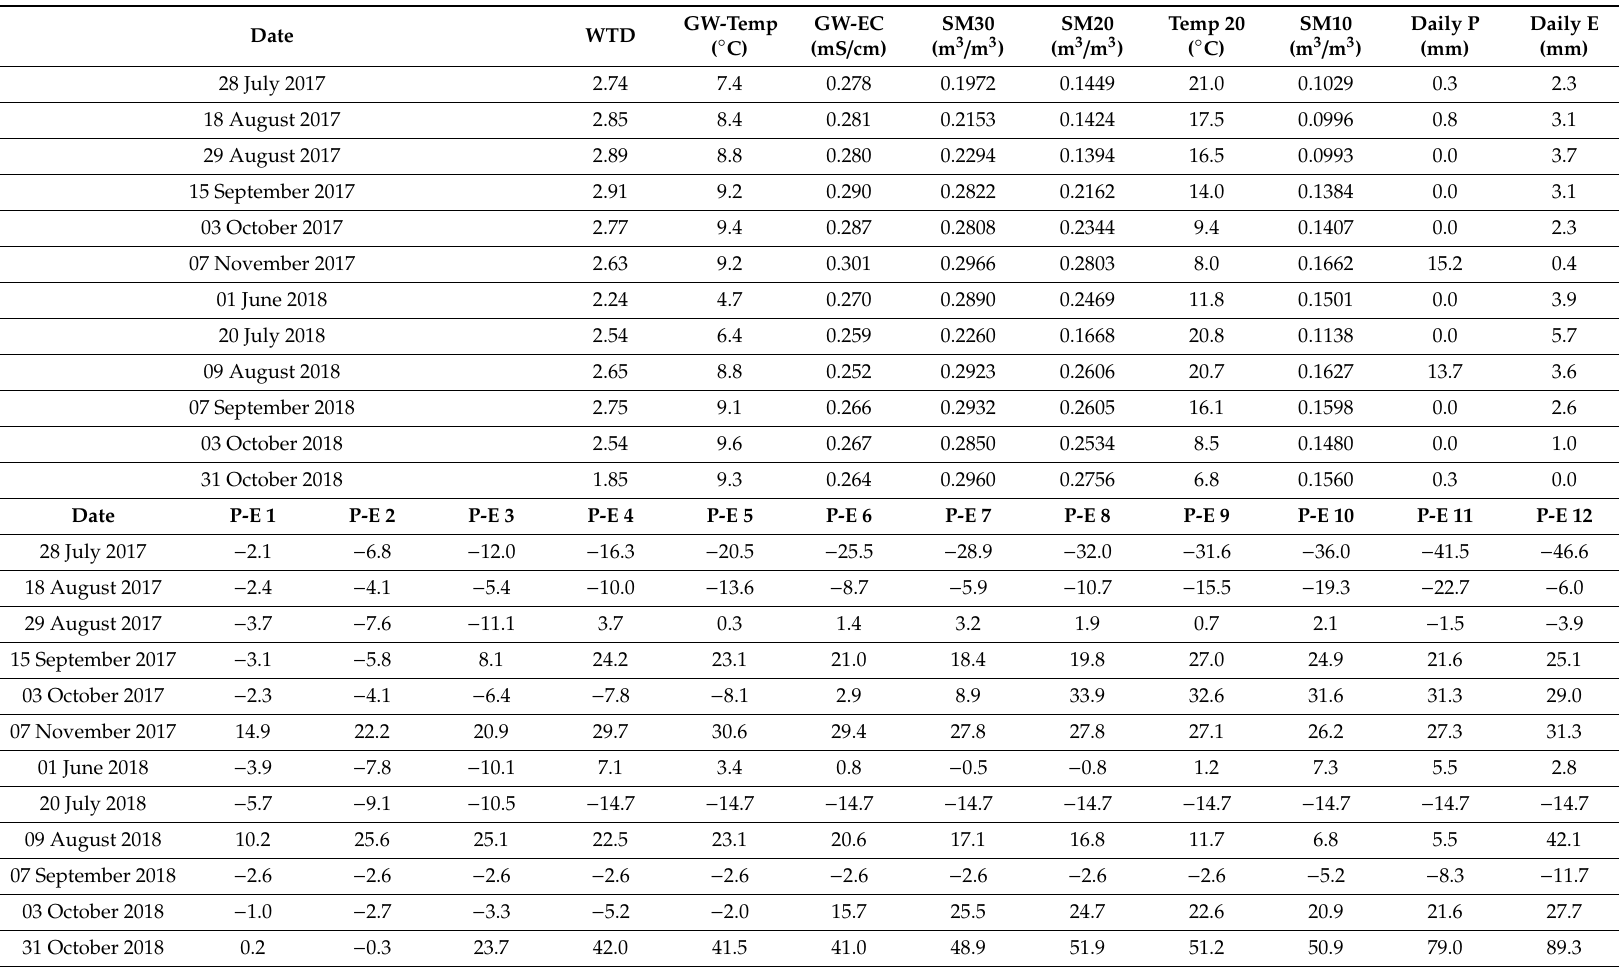
Table A3. Dataset for correlation